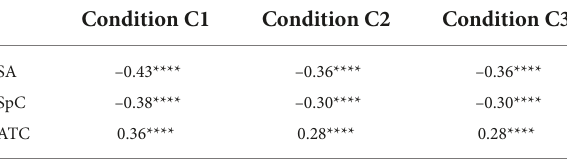
TABLE 2 Correlations between measures of the NCT and EME in three conditions. Condition C1 Condition